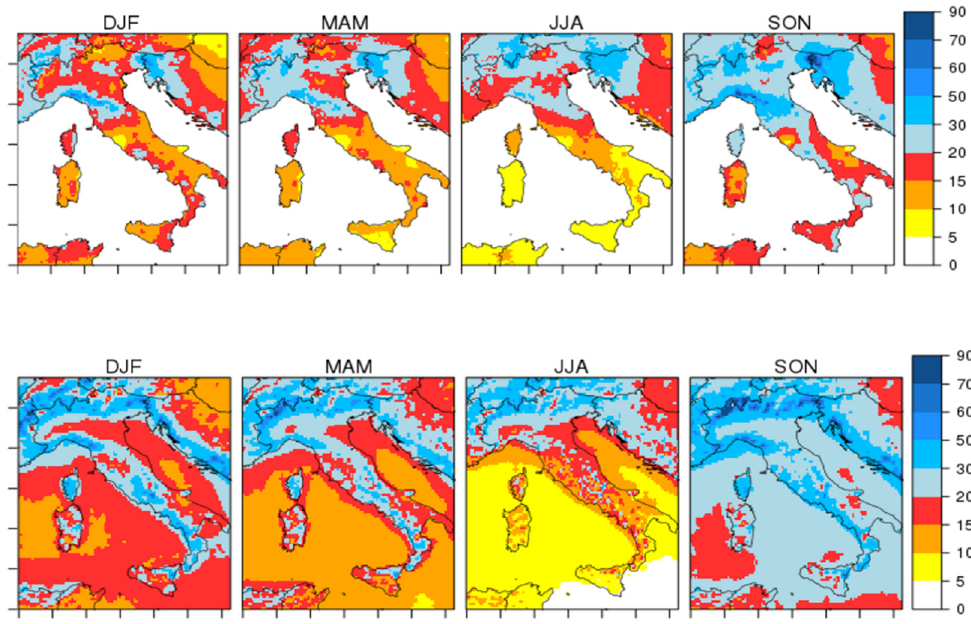
Figure 13. RR99 reference scenarios (expressed in mm/d) calculated at seasonal scale (DJF, MAM, JJA, SON), estimated using the base: E-OBS (top) and multi-model ensemble (bottom).